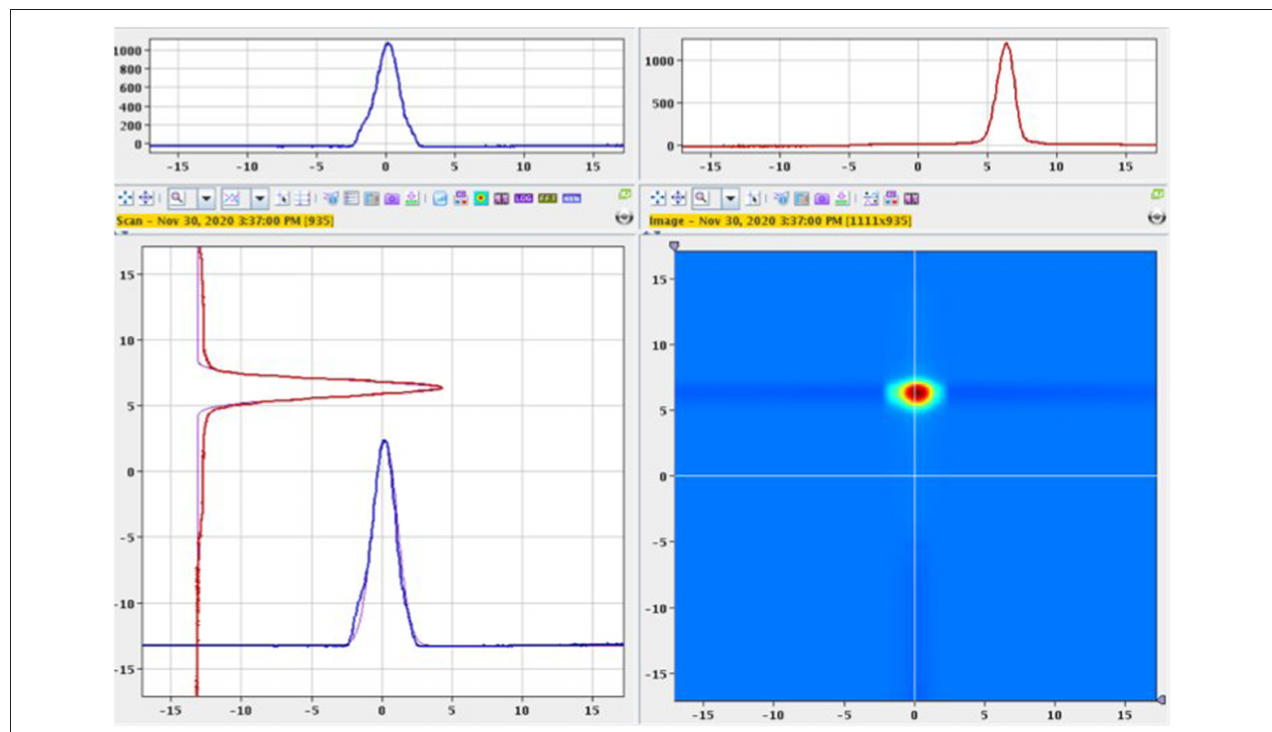
FIGURE 2 | 153 Sm beam profile with σ horizontal = 0.88mm and σ vertical =